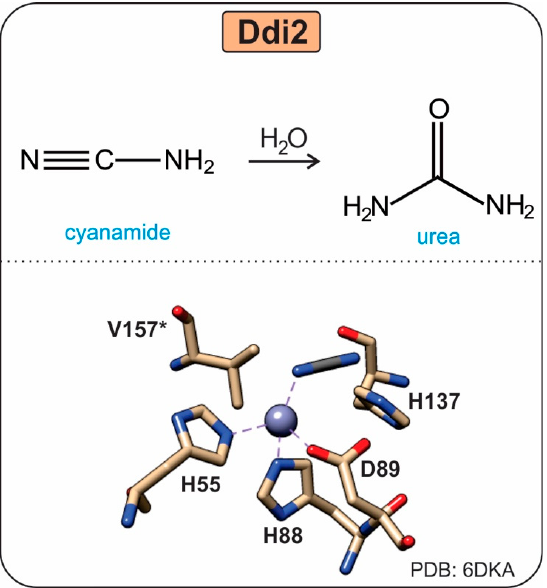
Figure 7. Reaction and active site of the HD-domain hydratase Ddi2. Ddi2 utilizes a Zn metal center to convert cyanamide to urea. The terminal aspartate residue found in HD-domain proteins is a replaced by a threonine in Ddi2. The role of this threonine, T157 (valine in the crystal structure), is predicted to allow for substrate positioning or metal specificity